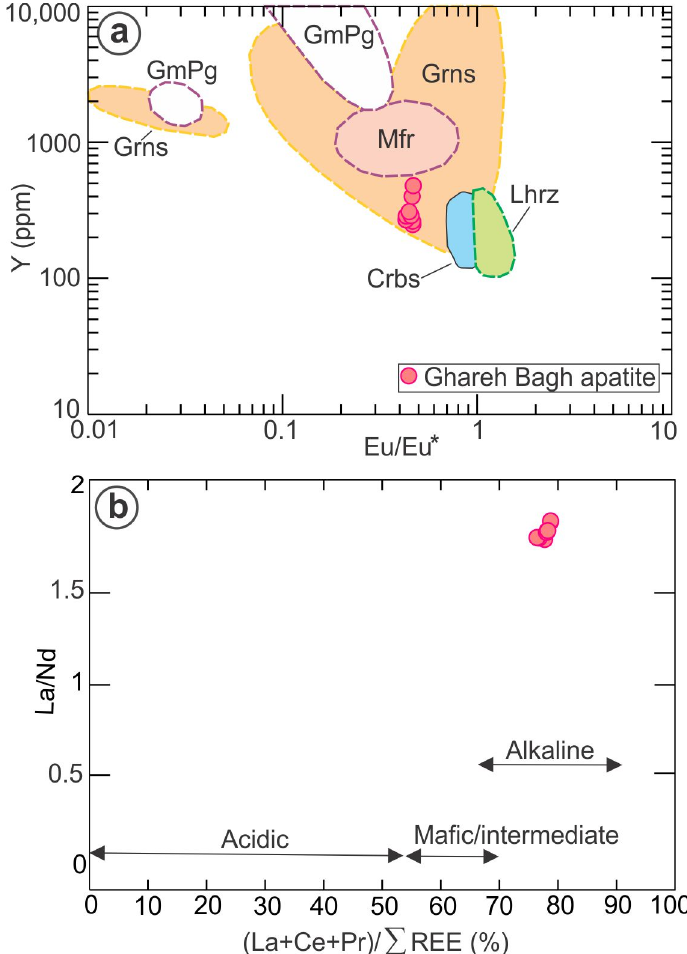
Figure 8. ( a ) Y vs. Eu / Eu* genetic diagram [2], showing composition from all of the studies rock. The apatite shows that they are derived from granitoid. ( b ) Apatite samples plot on the La / Nd vs. (La + Ce + Pr) / ⅀ REE (%) classification diagram of Fleischer and Altschuler [58]. Data indicate alkaline affinity. Abbreviations; Lhrz = lherzolites, Crbs = Carbonatites, Prx = Pyroxenites, Lrvk = larvikite, Dlr = dolerites, Grns = granitoids, GrnPg = felsic pegmatite and Mfr = mafic rocks.